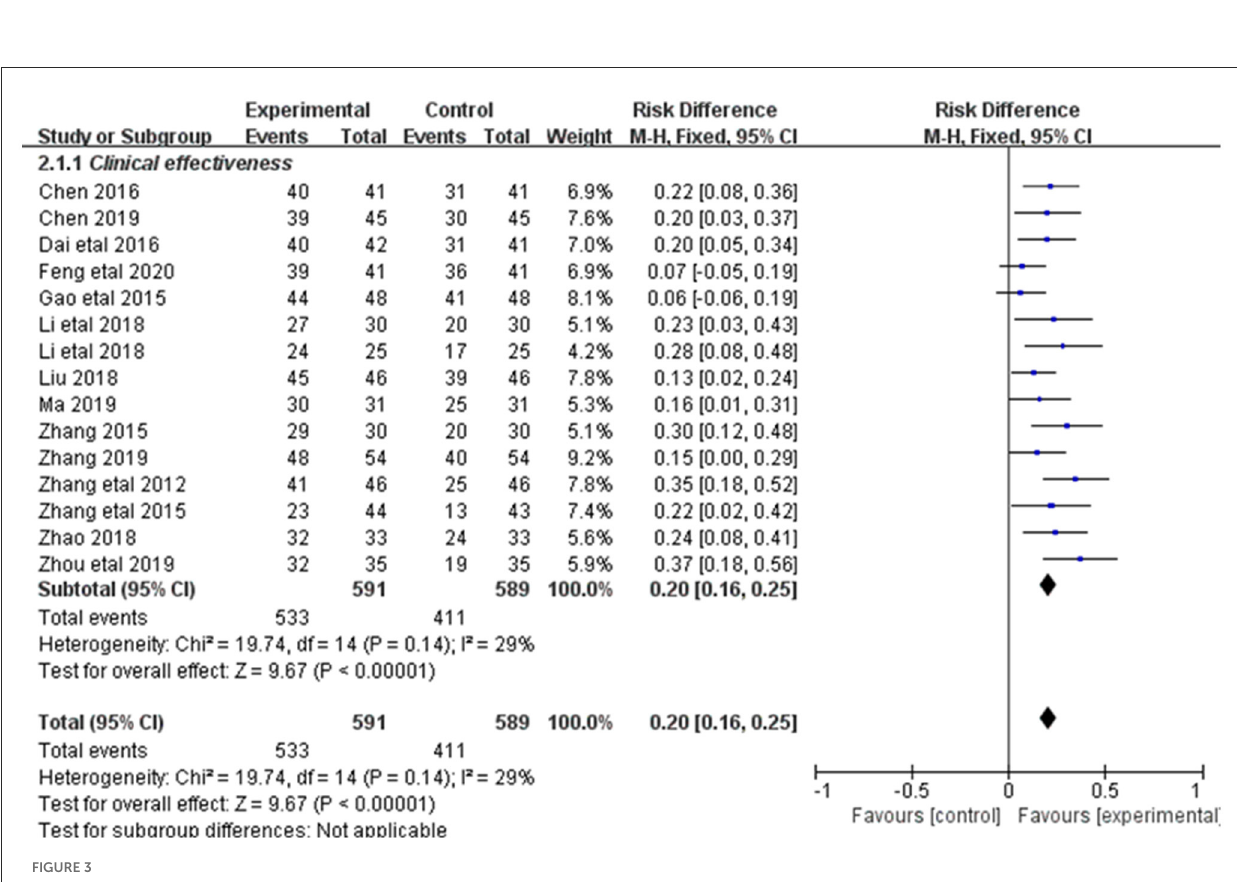
FIGURE3 Forest plot of the total effectiveness